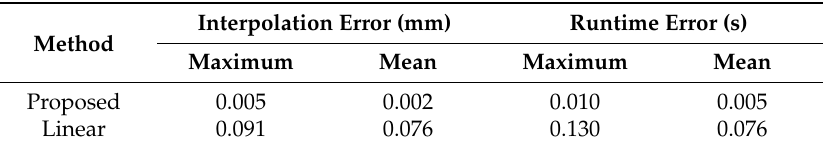
Table 2. Comparison of the effect of the two interpolation methods.